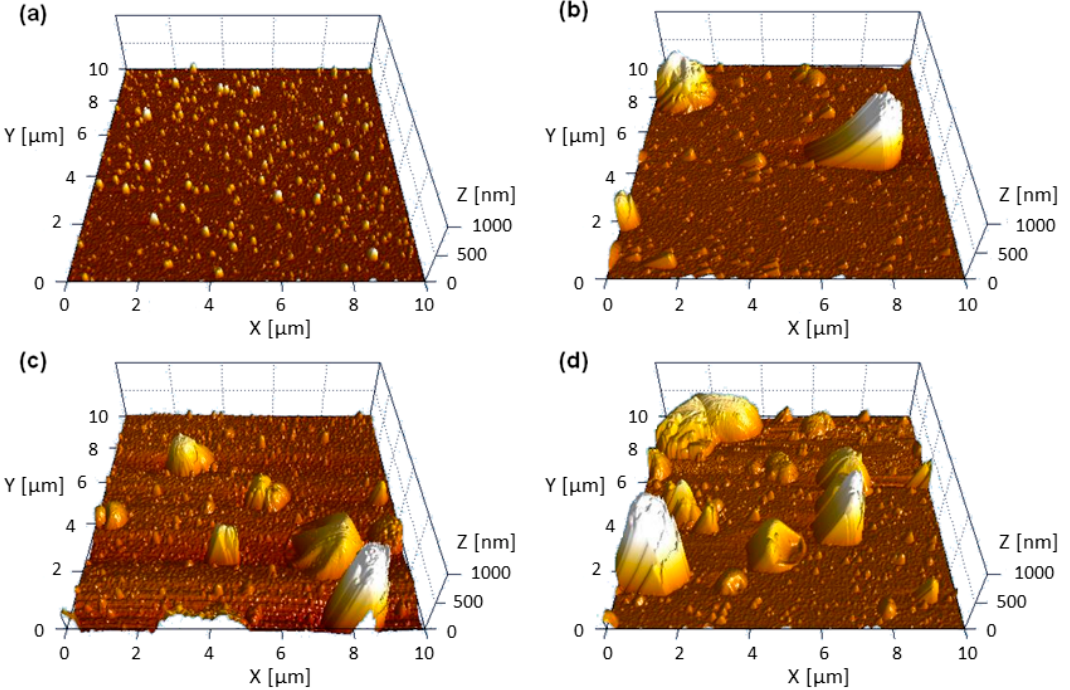
Figure 3. AFM surface topography images of Zn-SiO x films grown on Si with secondary precursor flow rates of ( a ) 0, ( b ) 25, ( c ) 50, and ( d ) 100 µl/min.